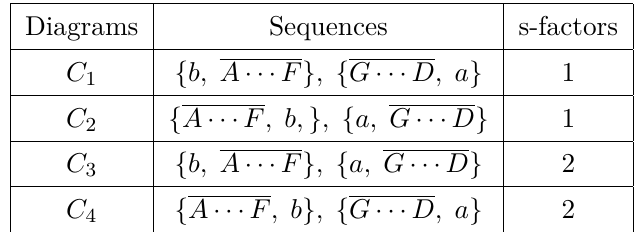
(1 , 1 , k + p, m + l, q + n ) 5